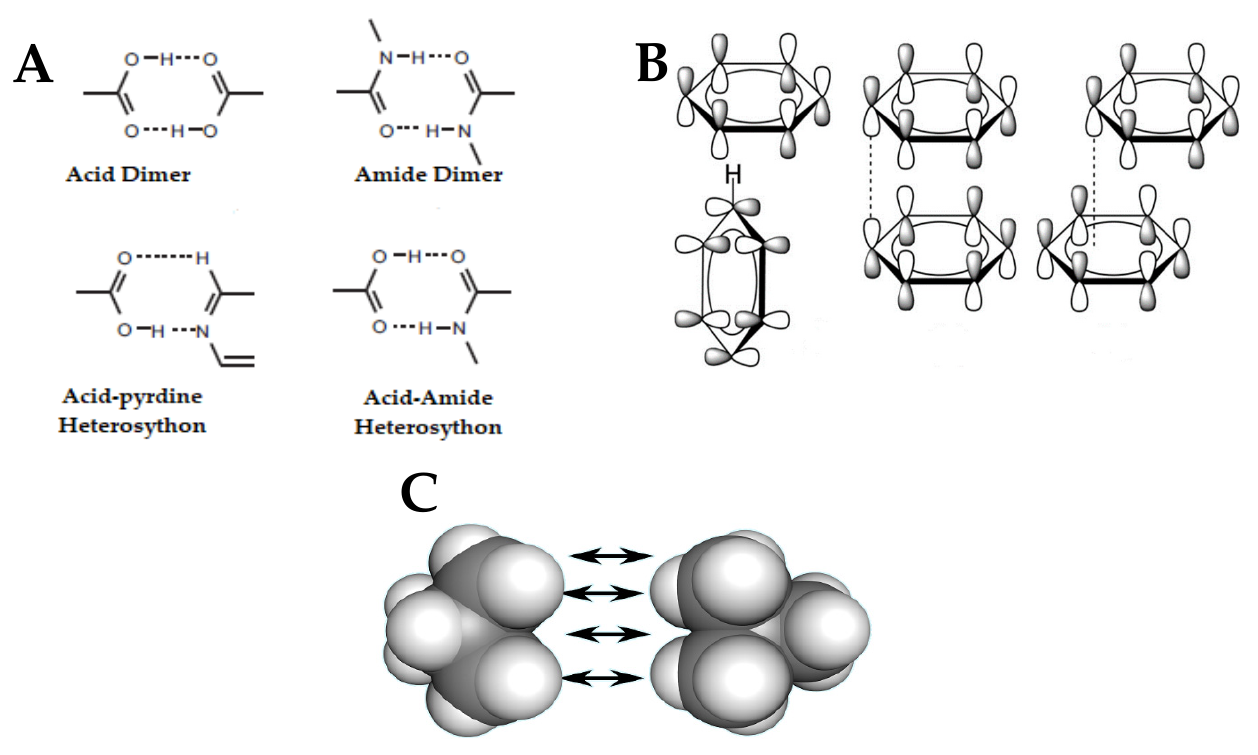
Figure 2. Depiction of the forces involved in co-crystal formation: ( A ) Hydrogen bonding (reproduced from [51]. Copyright 2022, copyright holder Elsevier, Amsterdam); ( B ) π – π stacking (reproduced from [52]. Copyright 2022, copyright holder Elsevier, Amsterdam); ( C ) van der Waals interactions (reproduced in accordance with https://creativecommons.org/licenses/by/4.0/, 23th of June 2022).